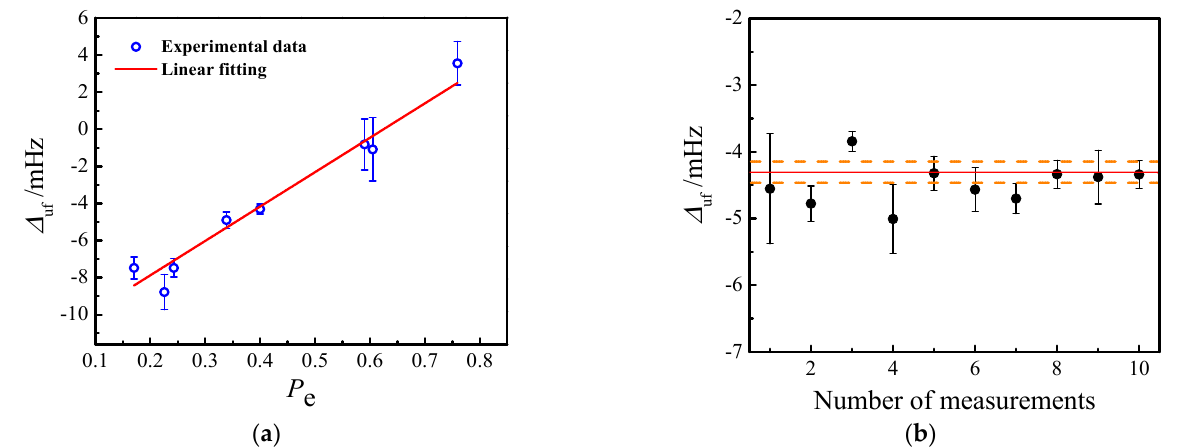
Figure 3. ( a ) The collisional shift of unit fluorescence intensity ( Δ uf ) at different excitation fraction. The error bars are given by the last point of the self-comparison instability. ( b ) The measurements of Δ uf when the excitation fraction is about 0.4. The measurement uncertainty is also given by the last point of the self-comparison instability. The solid line indicates the weighted average of the ten measurements of which the value is same as the corresponding data in ( a ) where P e is about 0.4. The dashed lines represent the 1 σ standard deviation of the average value that has been multiplied by the square root of the χ 2 = 2.06.